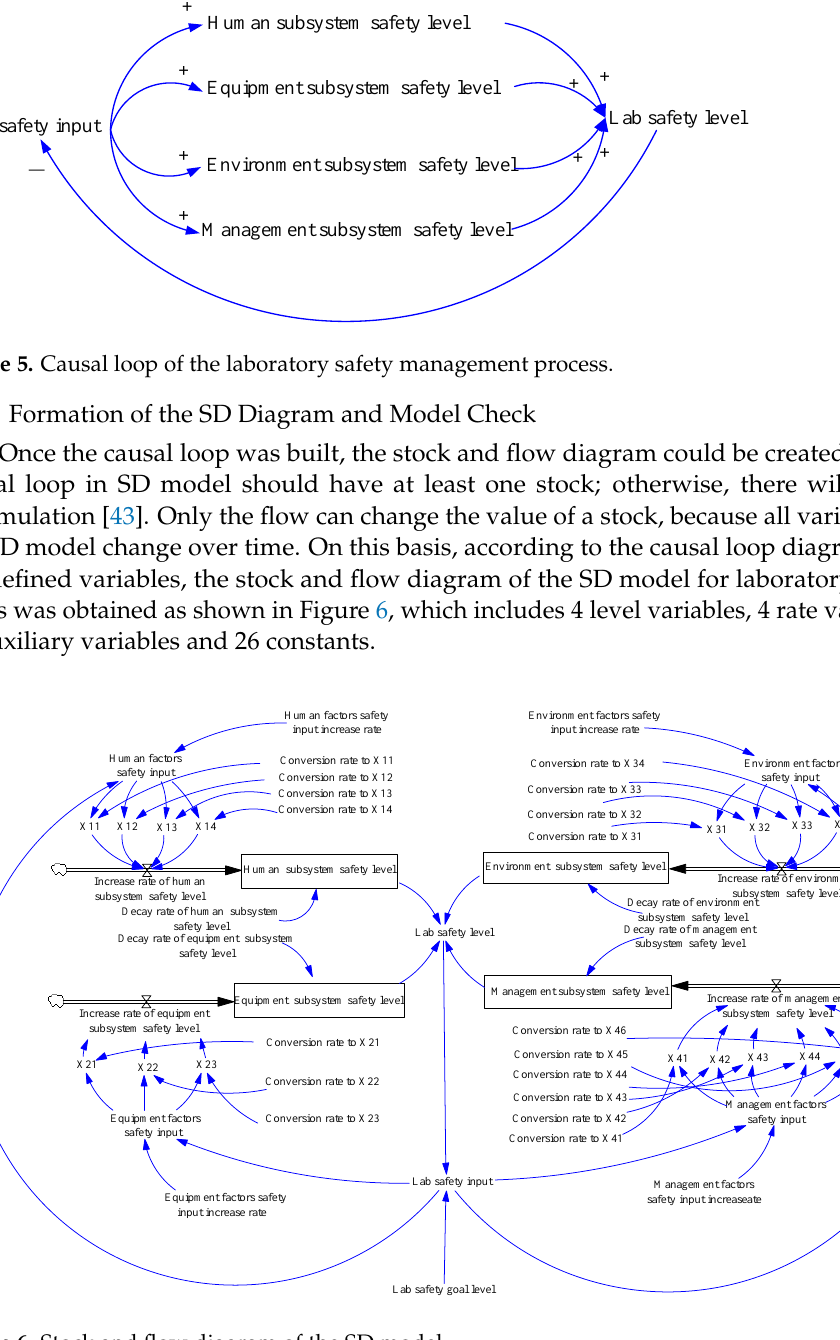
Table 9. Variables and functions in the SD model.